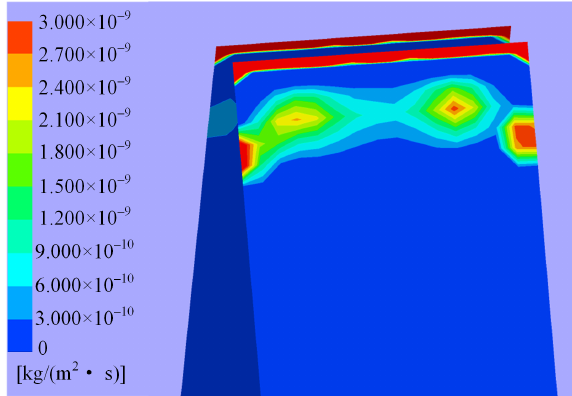
Figure 13. Erosion rates of shunt wedge’s outer surface.